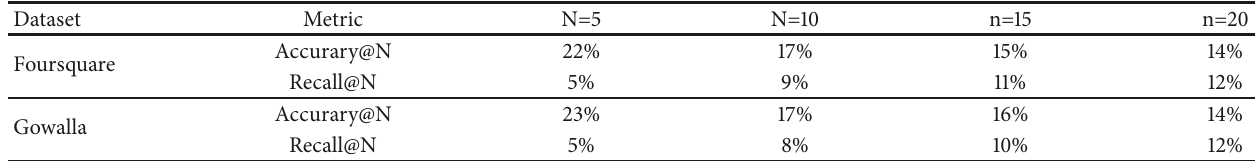
Table 1: Performance of LSTM-based POI recommendation algorithm.